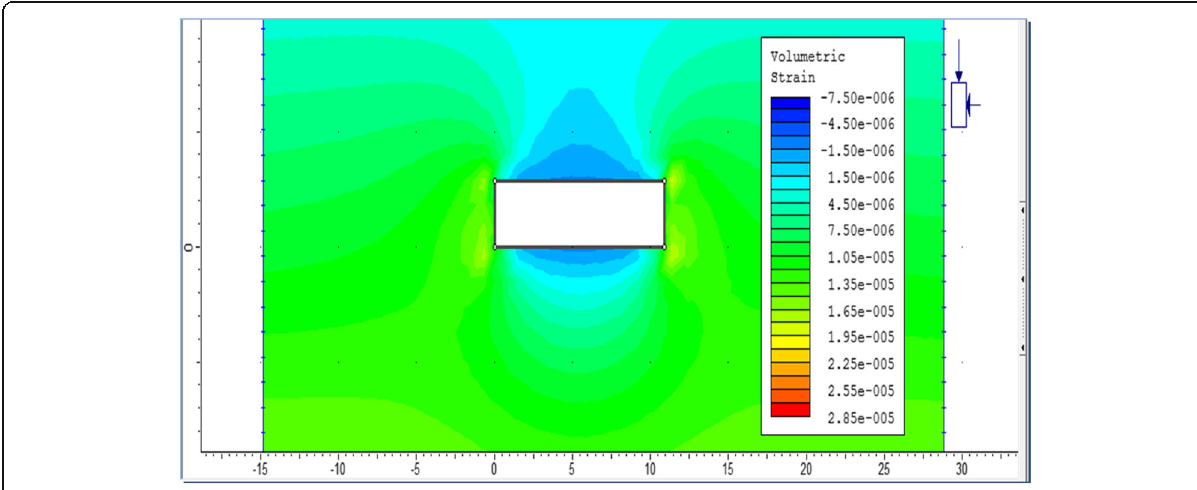
Fig. 20 Volumetric strains of the ceiling and sidewalls of northern Chamber. Examine